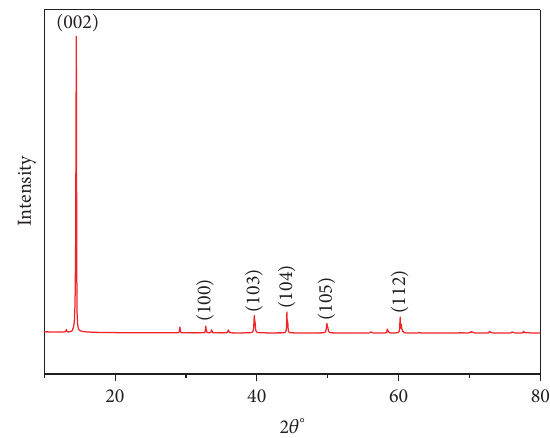
Figure 9: XRD pattern of MoS 2 catalyst.